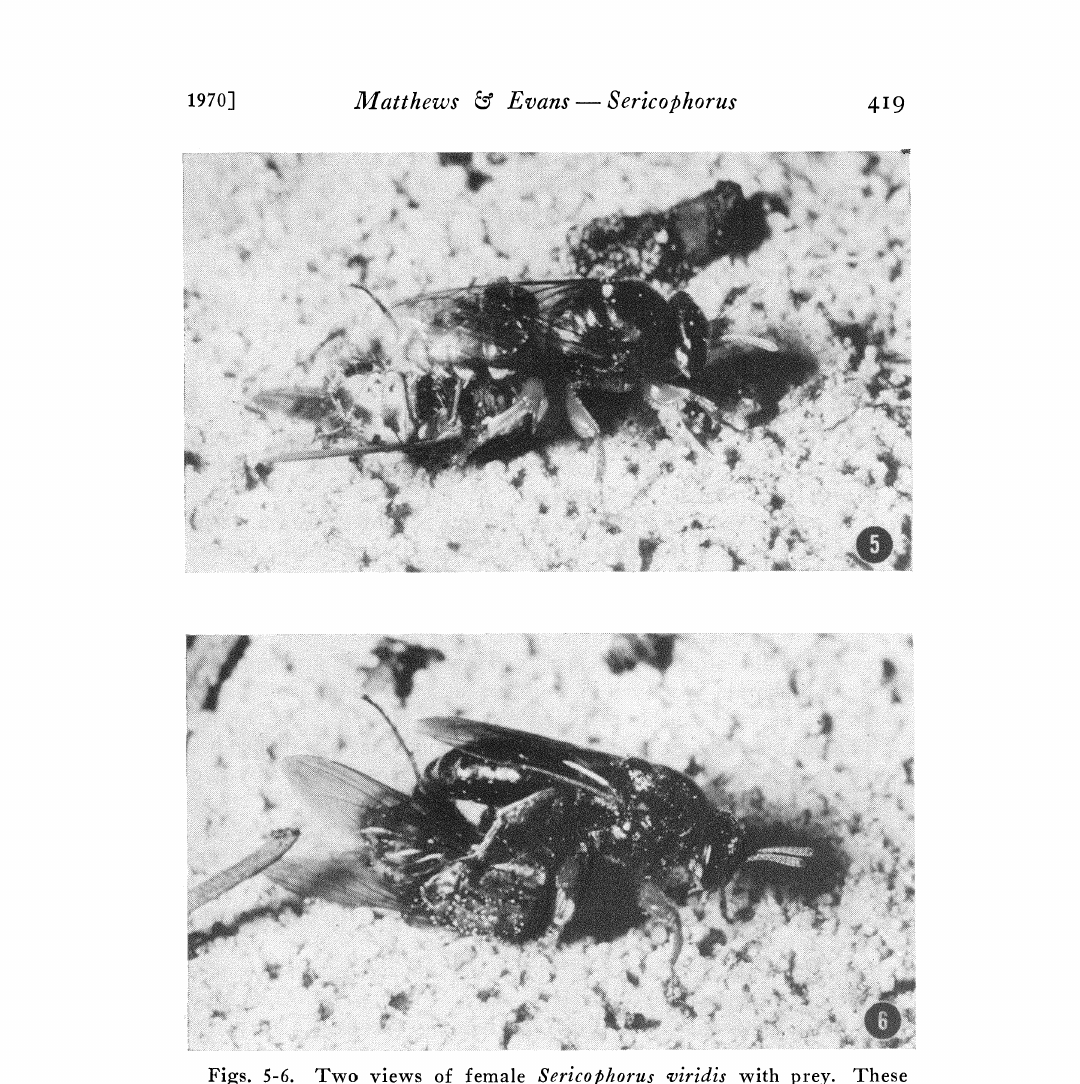
Figs. 5-6. Two views of female Sericophorus iridis with prey. These females have landed on the ground near their nests and will shortly pro- ceed to them. Note that the fly is held well back, beneath the abdomen of the wasp, the hind legs embracing the back of the fly’s thorax. In most eases the fly is renter-up, as in Fig. 5; carriage of the fly sideways (Fig. 6) is